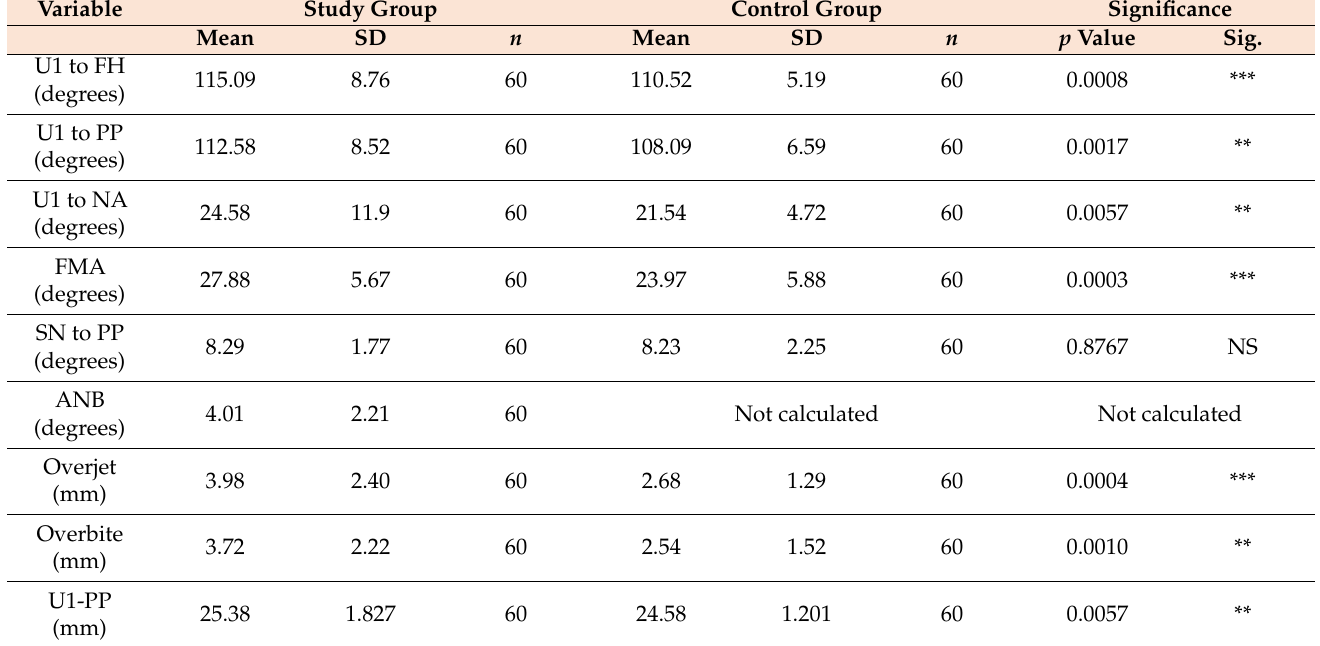
Table 3. Comparison of the angular (degree), linear and ratio measurements in two